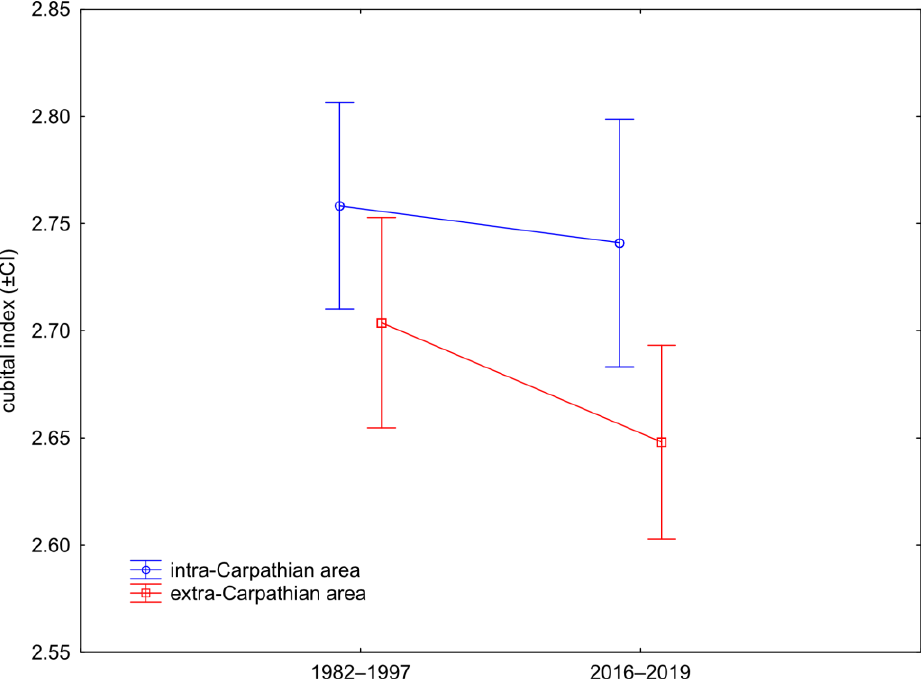
Figure 4. Differences in the cubital index (±95% confidence intervals) between the intra- and ex- tra-Carpathian samples collected in the years 1982–1997 and 2016–2019. Carpathian samples collected in the years 1982–1997 and